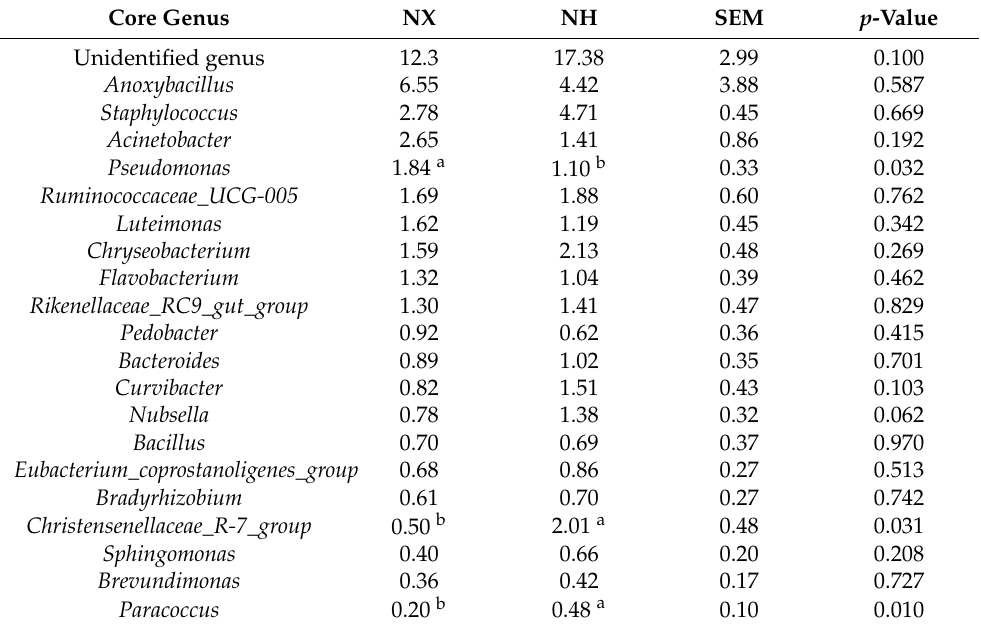
Table 2. The core genus across 100% of the collected colostrum samples from the two farms and their relative abundance